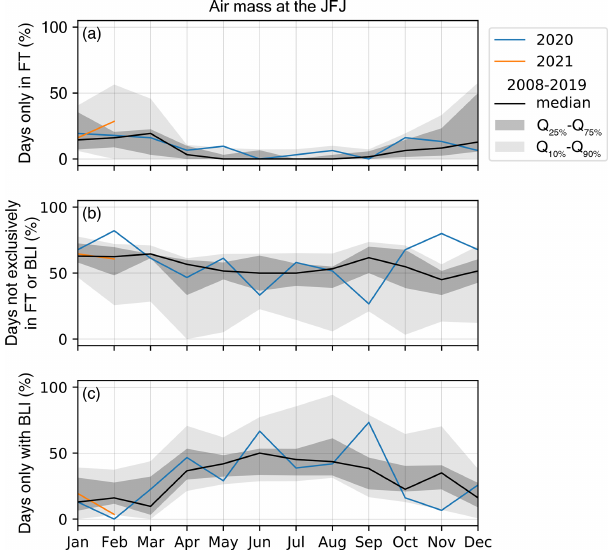
Figure 1. Fraction of days (a) entirely in FT air masses, (b) in both FT and BLI air masses, and (c) only in BLI air masses for 2020 (blue), January–February 2021 (orange), and 2008–2019 (gray). Q 10% , Q 25% , Q 75% , and Q 90% correspond to the historic 10th, 25th, 75th, and 90th percentiles between 2008 and